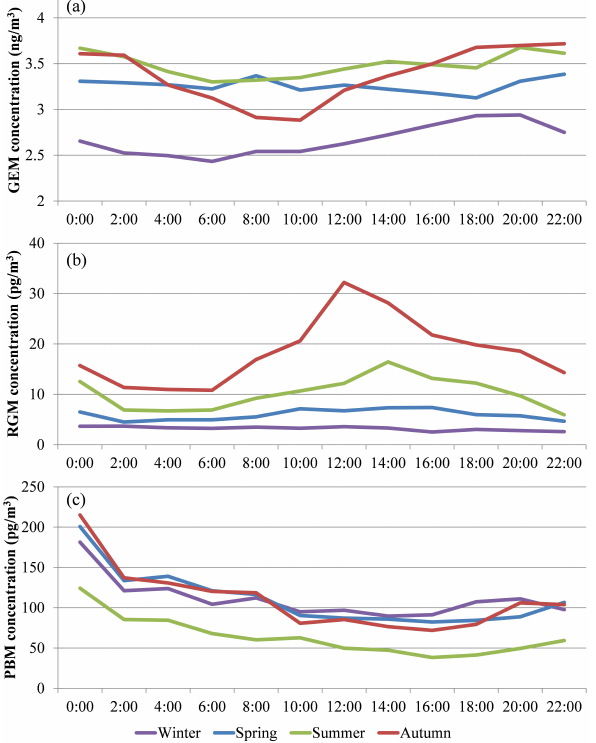
Fig. 4. Daily variation of (a) GEM, (b) RGM and (c) PBM concen- tration.